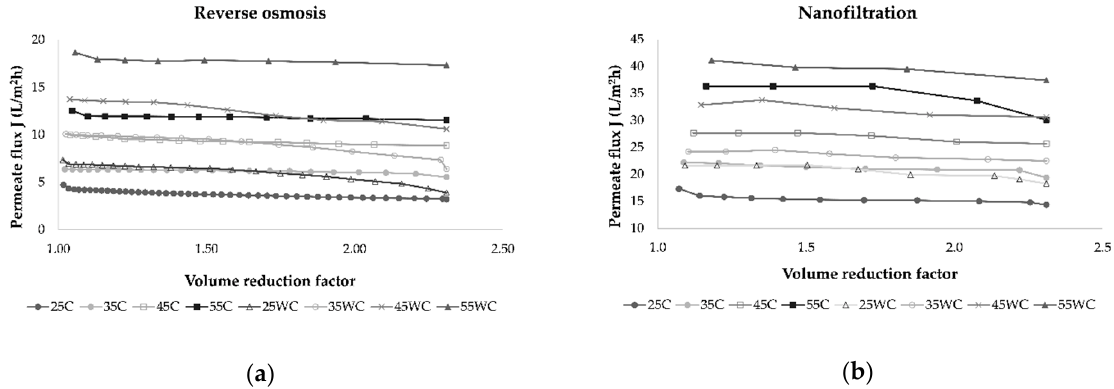
Figure 2. Influence of retentate concentration index (I rt ) on permeate flux (L/m 2 h) during concentration of Cabernet Sauvignon red wine by reverse osmosis ( a ) and nanofiltration ( b ) at 25, 35, 45, and 55 bar, with (C) and without cooling